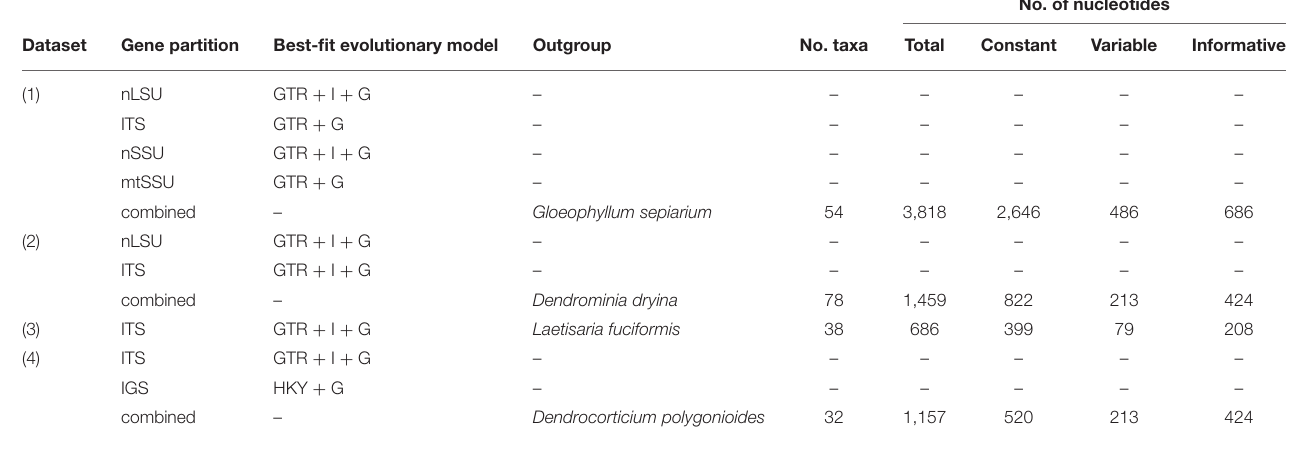
TABLE 2 | Characteristics of the datasets in this